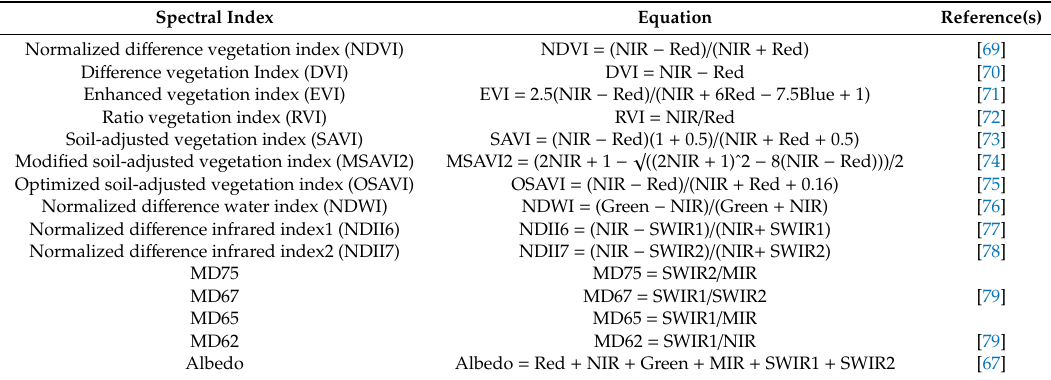
Table 3. A summary of equations used for calculation of spectral